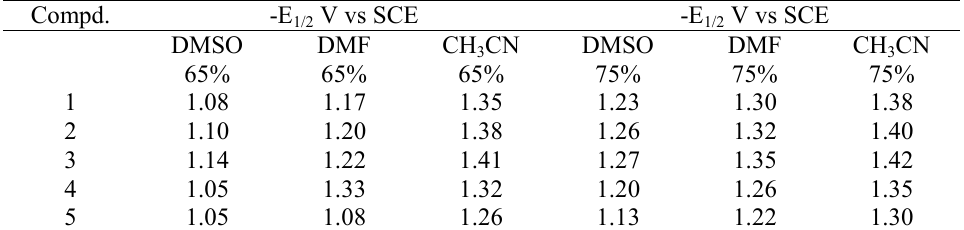
of compounds 1-5 Conc. = 1 mM, pH = 4.0. 1/2